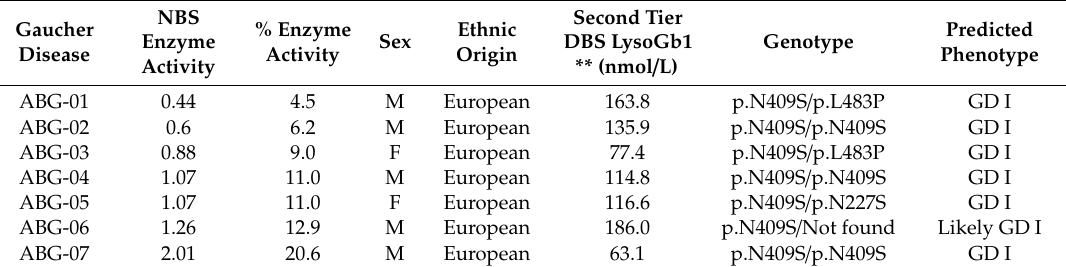
Table 4. NBS enzyme activity, confirmatory testing results and final diagnosis in newborns with suspicion of Gaucher Disease. Newborns were ordered based on neonatal screening enzyme activity. Gaucher